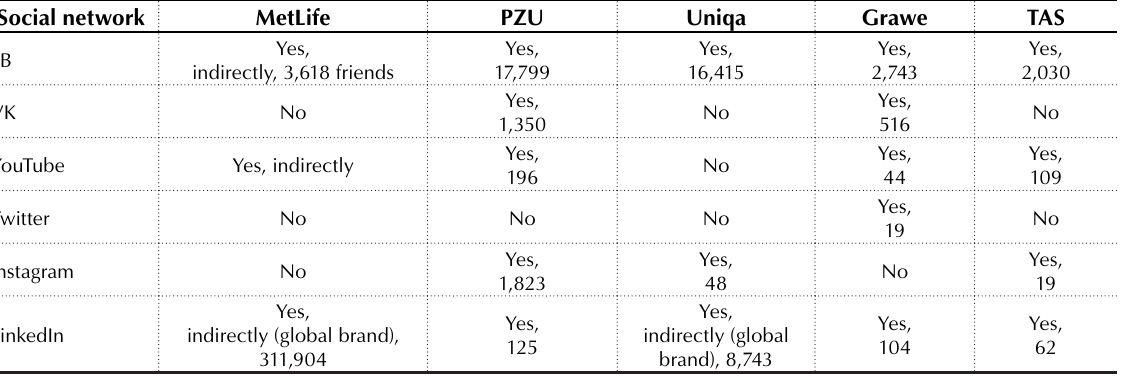
Source: Sites of the companies.